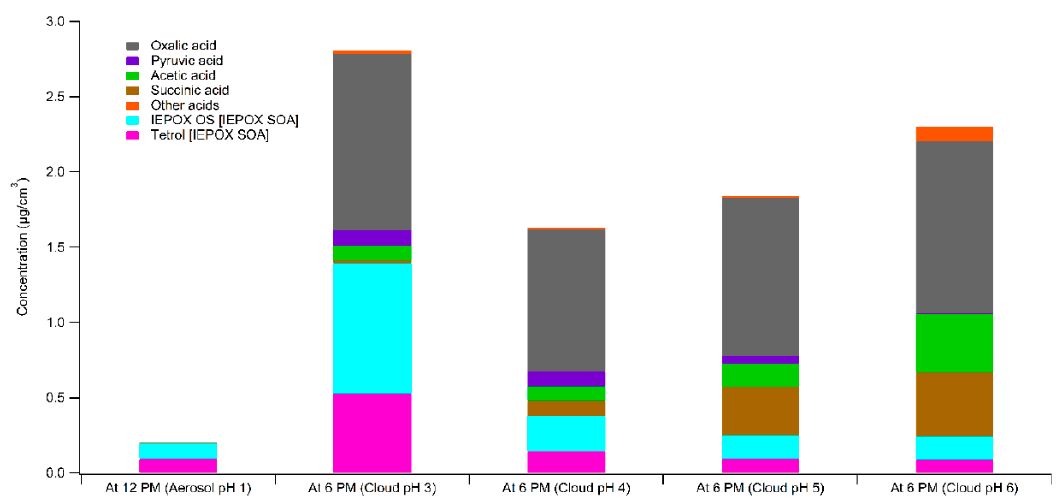
Figure 3. Organic acids and IEPOX SOA in the aqueous phase in Simulation 1 with aerosol pH 1 and cloud pH 3 to 6. The graphs for cloud pH 3 to 6 indicate composition at the end of the simulation at 6 p.m. Concentrations are given in mass per volume of air parcel.